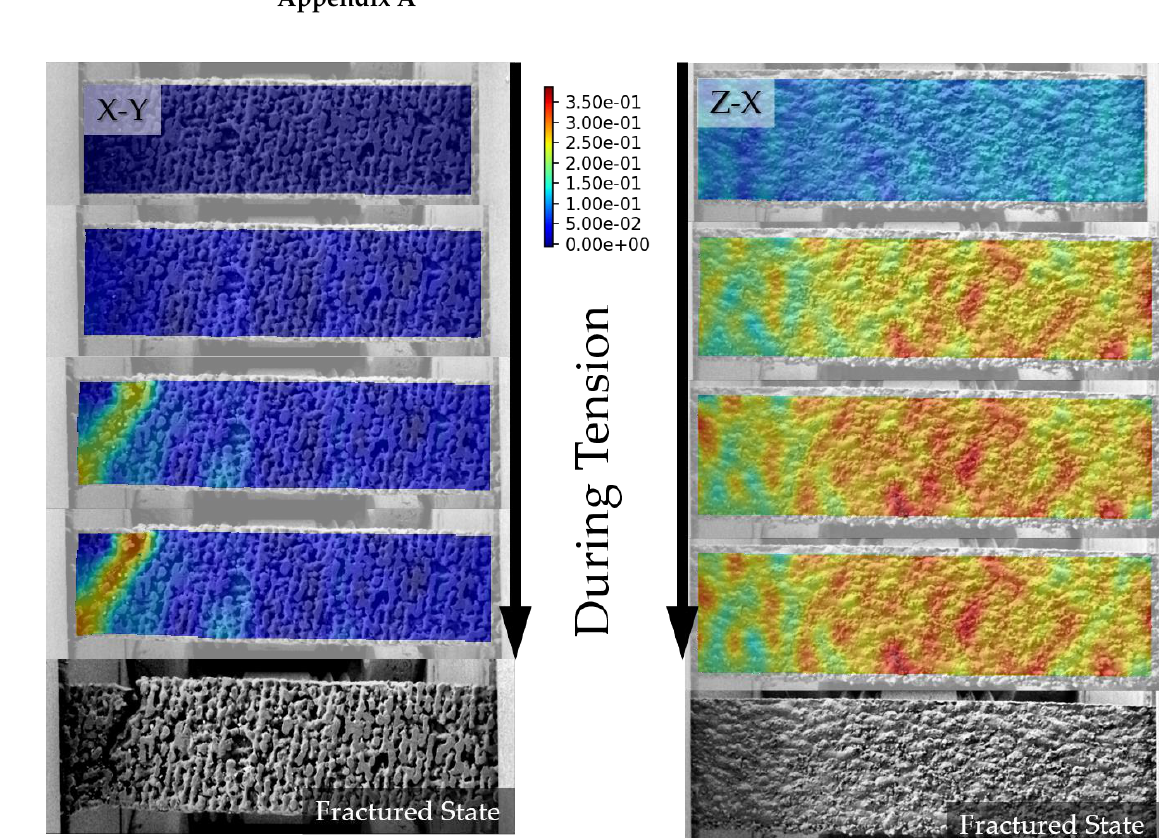
Figure A1. 2D strain distributions along loading axis for samples with different printing orientations: ( left ) X-Y and ( right ) Z-X.